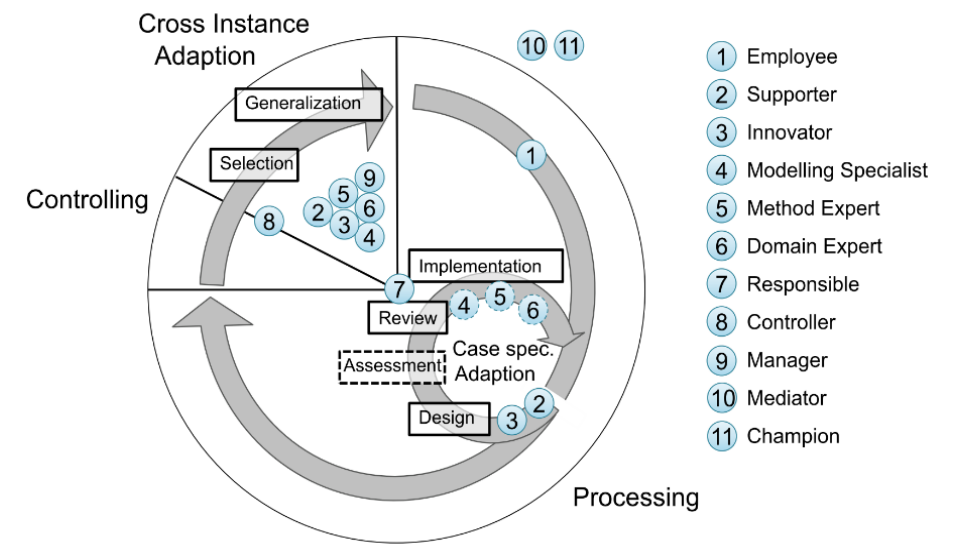
Figure 2. Process and Role Model by Hermann and Kurz, adapted from